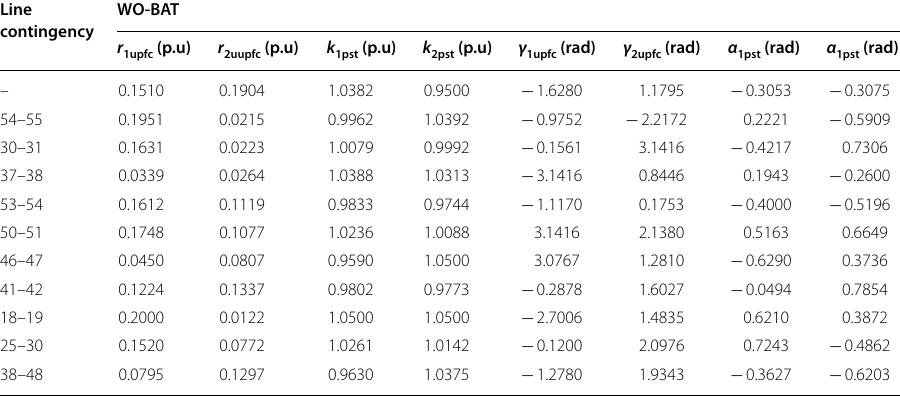
Table 6 Control parameters of GOUPFC under single line contingency and 0.5 RES